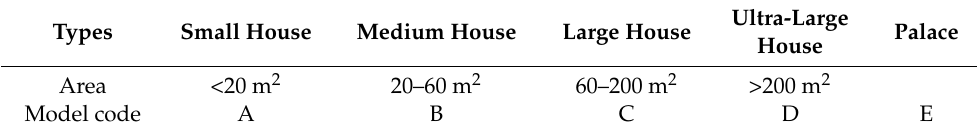
Ultra-Large Palace House